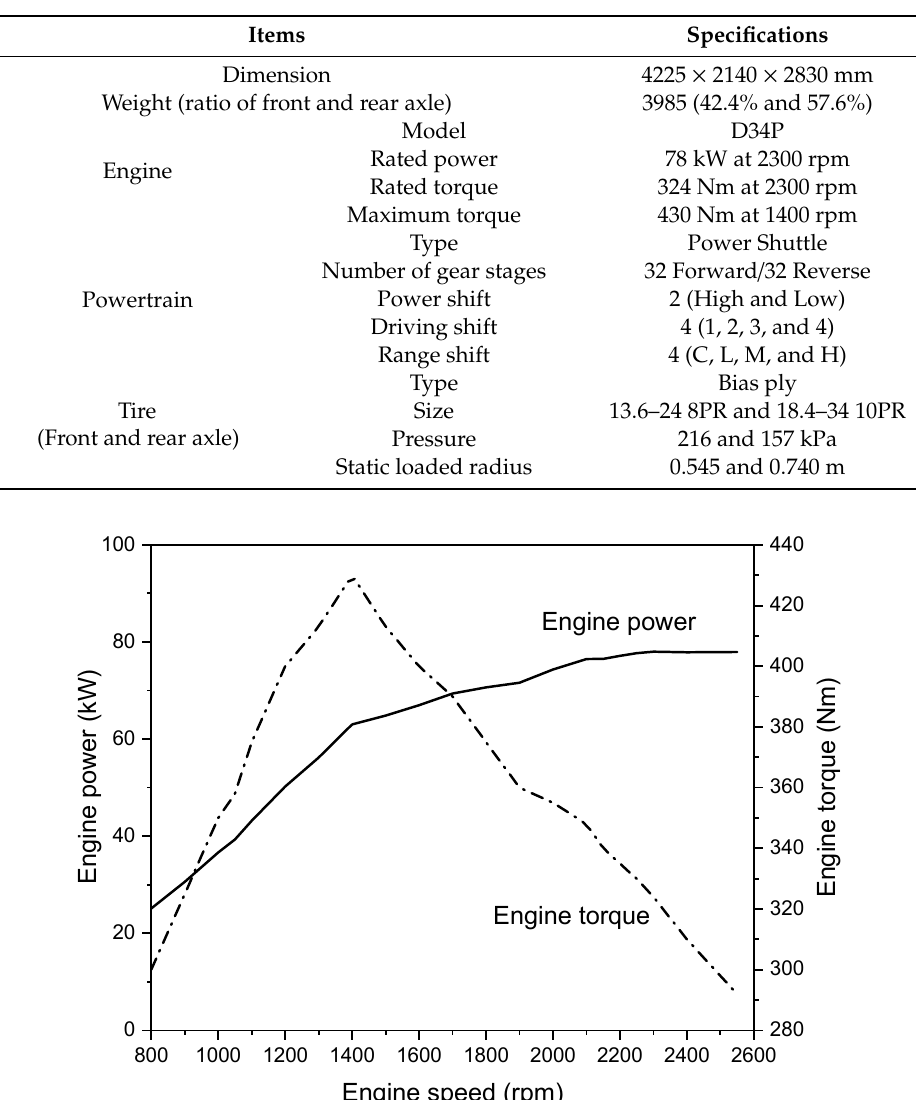
Table 1. Specifications of agricultural tractor used in this study.